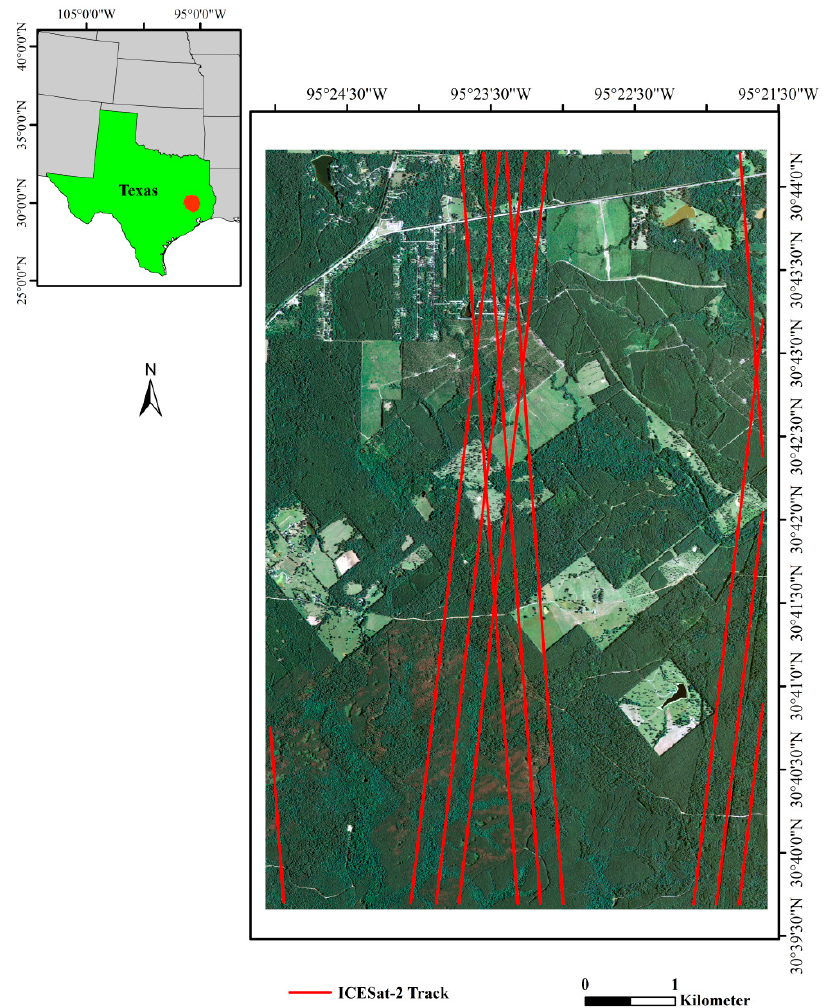
Figure 1. ICESat-2 tract locations overlaid on 2010 National Agriculture Imagery Program (NAIP) aerial imagery within SHNF, Texas (inset map, upper left corner).